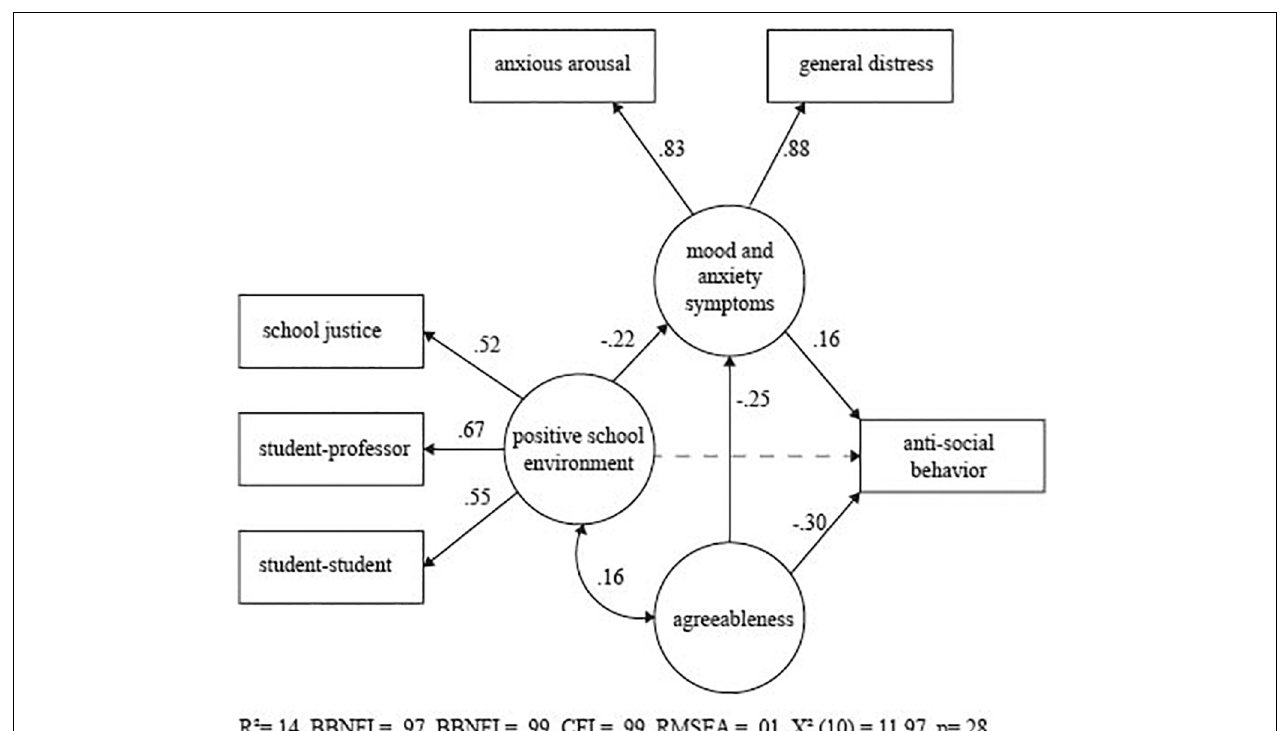
FIGURE 2 | Structural equations model of protective enviromental and personality factors for antisocial behavior. All factor loadings, structural coefficients, and covariances were significant ( p < 0.05); except one marked with dotted line. The model demonstrated acceptable Goodness of Fit [ χ 2 (10) = 11.97, p = 0.28; BBNFI = 0.97, BBNNFI = 0.99, CFI = 0.99, RMSEA =